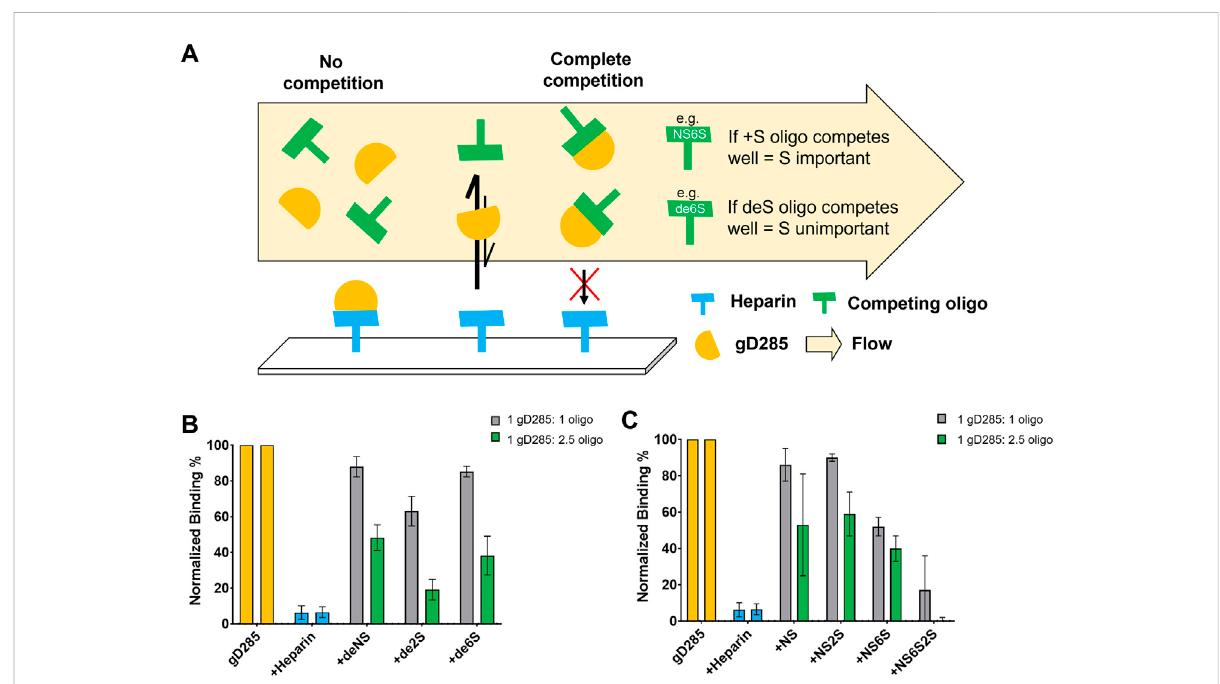
FIGURE 4 Competition SPR with chemically de-sulfated heparin and sulfated heparosan oligosaccharides reveals 6- O -sulfation as key to gD-HS interaction. (A) Scheme of competition SPR with de-sulfated (deS) heparin ligands, where binding re fl ects how important the absent sulfate group is to gD/HS interaction. (B) Normalized, average binding percentage of 0.1 µM gD285 injected onto a heparin-immobilized chip pre-mixed with various de-sulfated (+deNS, +de2S, +de6S) heparin oligosaccharides at 1:1 and 1:2.5 M ratios. No oligosaccharide (gD285) and unmodi fi ed heparin were used as negative and positive controls, respectively. (C) Normalized, average binding percentage of 0.1 µM gD285 pre-mixed with various sulfated heparosan oligosaccharides (+NS, +NS2S, +NS6S, +NS6S2S) at 1:1 and 1:2.5 M ratios injected over a heparin immobilized SPR chip. Error bars denote the SD of three replicate fl ow